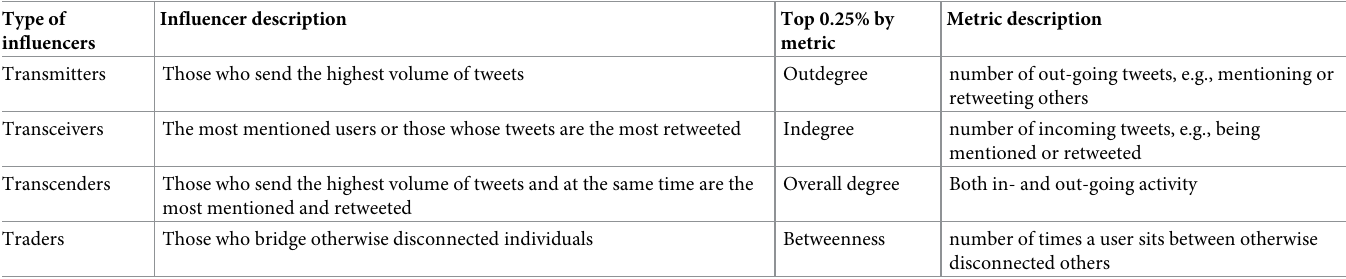
Table 2. Description of type of influencers, 2020 World Breastfeeding Week